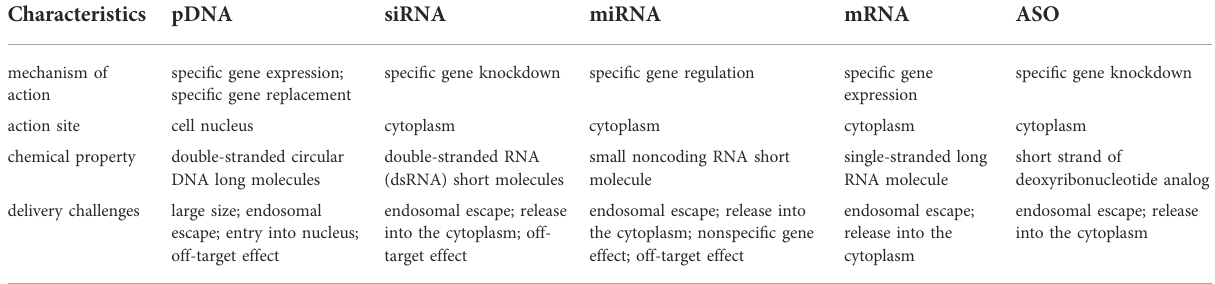
TABLE 1 The characteristics ’ comparison of nucleic acid-based therapeutics.